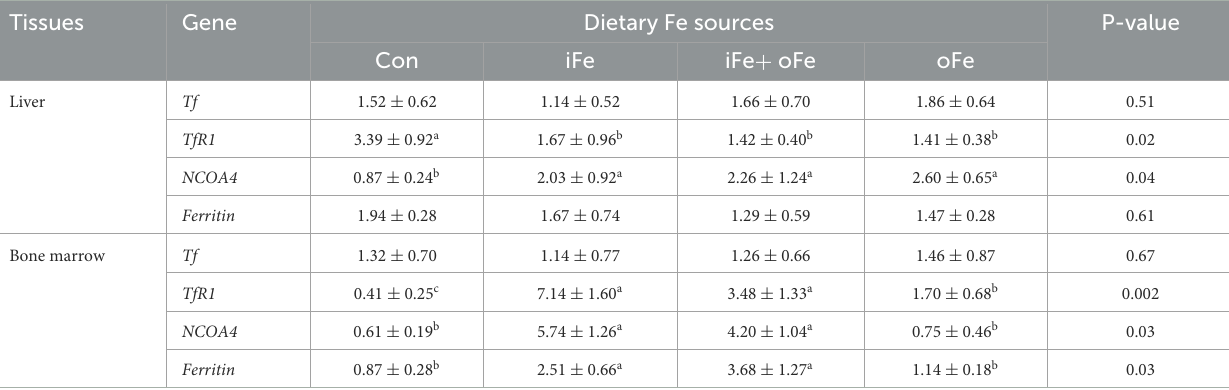
TABLE 6 Effects of different dietary iron sources on gene expression related to related to iron homeostasis in tissues of weaned piglets at d 70.